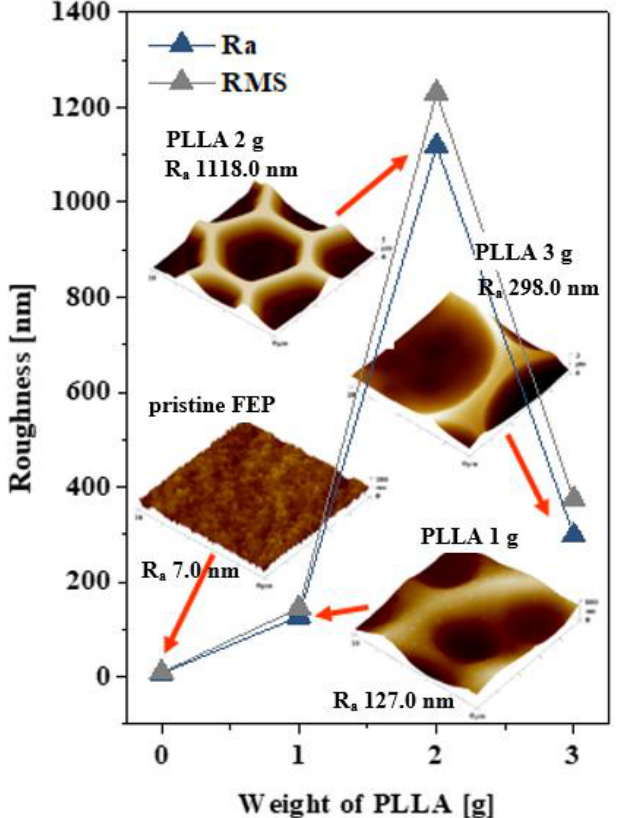
Figure 5. The surface roughness (R a , RMS) and corresponding images obtained from atomic force microscopy (AFM) of unmodified FEP (pristine) and FEP foils modified at 8 W and 240 s, and then immersed in polymer solution containing 1, 2, or 3 g of PLLA. AFM images of 10 × 10 µ m 2 were introduced.